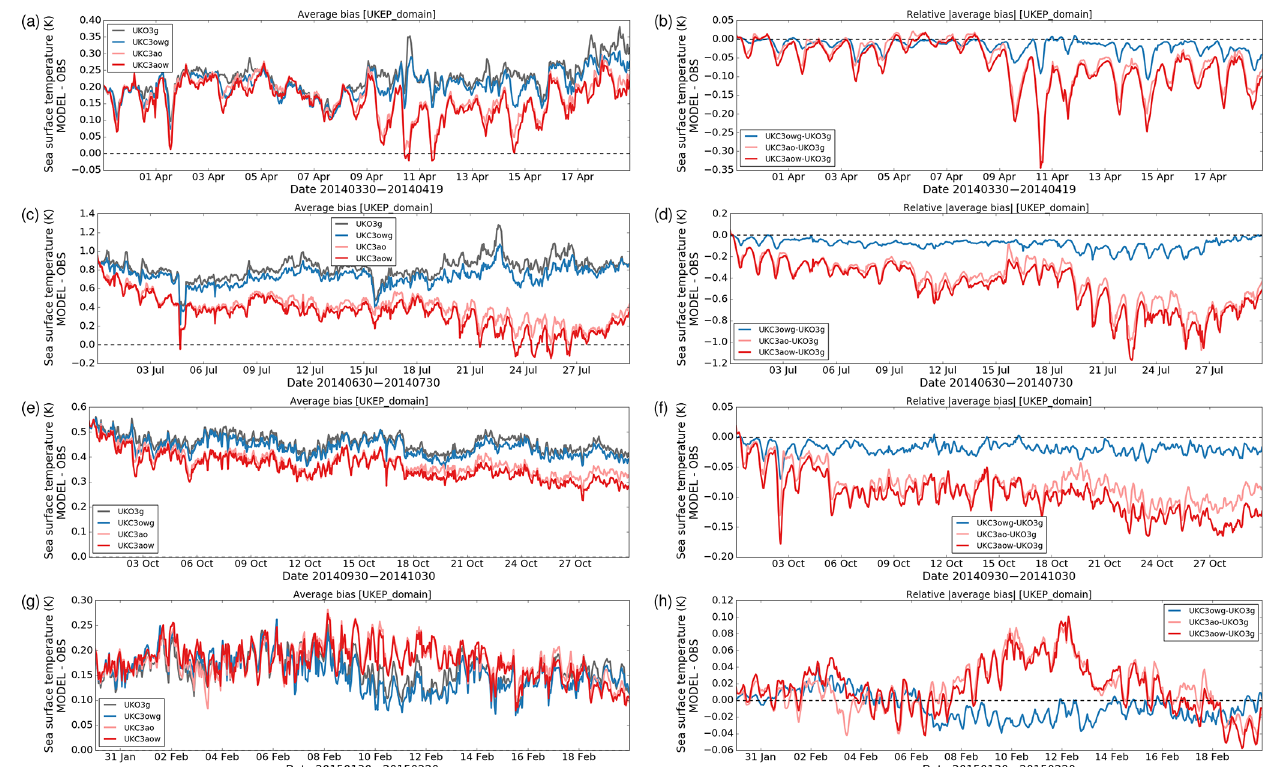
Figure 4. (a, c, e, g) Time series of average model–observation (MODEL–OBS) bias of ocean model sea surface temperature across all observing sites for each simulation for July, April, October 2014 and February 2015, respectively. (b, d, f, h) Differences in absolute | MODEL–OBS | bias for each simulation period relative to UKA3u. A negative relative | average bias | indicates the coupled system to have a lower average absolute bias across all observation sites than the control. Note that plots have different scales across the different months evaluated, and observations are compared with a nearest neighbourhood mean of 3 by 3 model grid